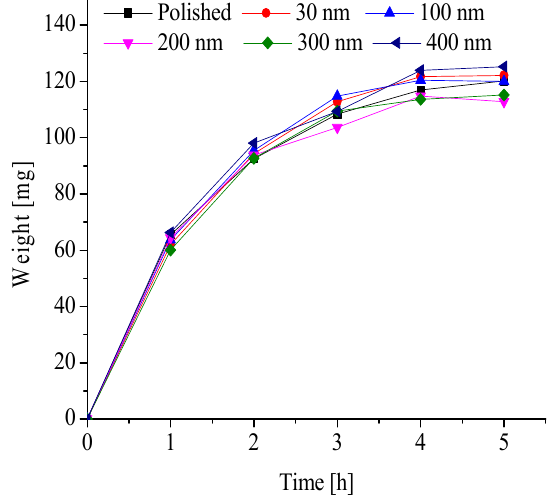
Figure 20. Variations of frost weight with different nanoporous diameters at T = − 25 °C, φ = 90%.